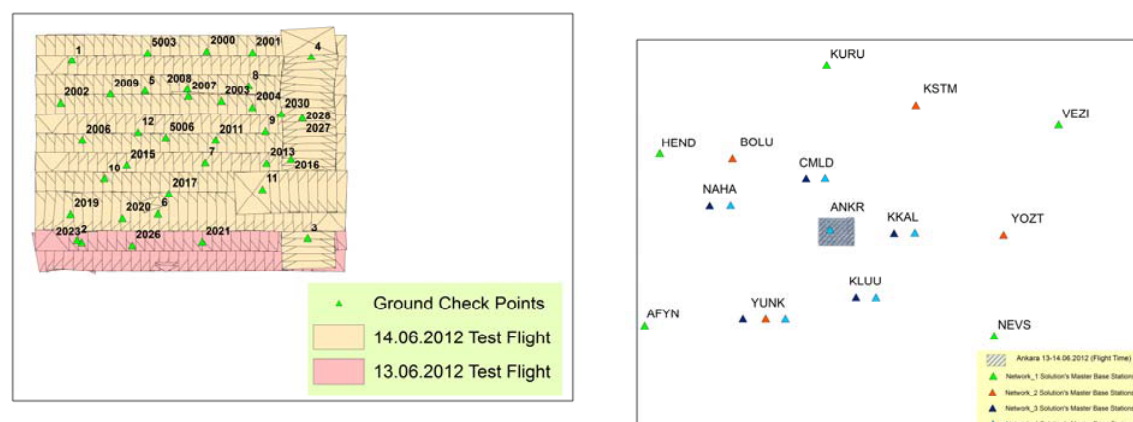
Figure 1. Distribution of check points